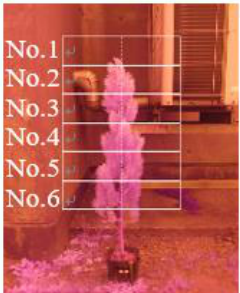
Figure 19. NIR image dividing into 6 blocks